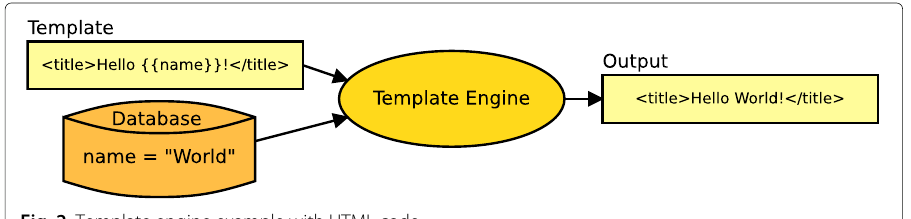
Fig. 2 Template engine example with HTML